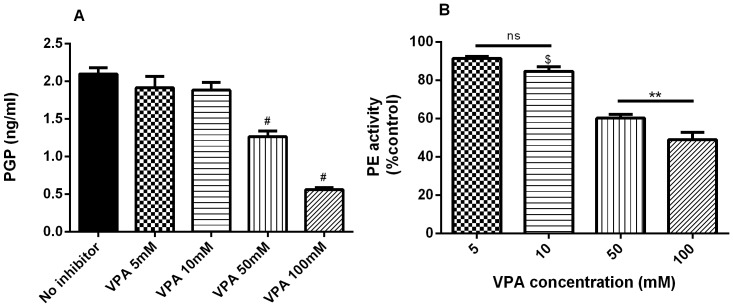
Inhibition of PGP generation by VPA.(A) Dialyzed Collagen Type I and II were incubated with the lysate of 4.6 * 106 PMN at 37°C for 20 hours to generate PGP. (B) PE activity was measured 30 minutes after incubation of lysate/collagen/VPA mixture and compared to control (no VPA). Data are shown as the mean ± S.E.M. (n = 5–10 per group). Representative of 4 experiments. # p<0.0001 compared to control, $ p<0.01 compared to control, ** p<0.01, ns p>0.05.